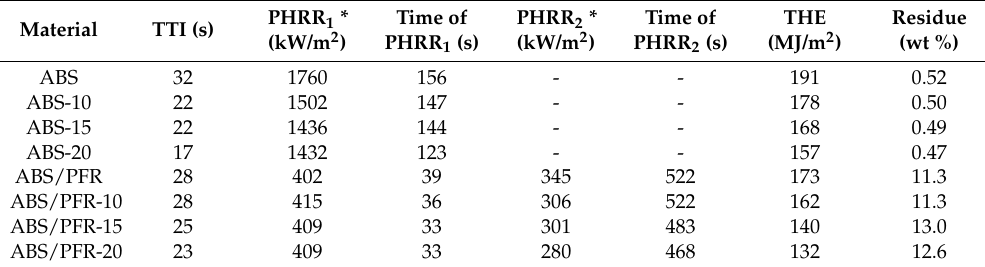
Table 3. Results obtained from cone calorimeter tests.